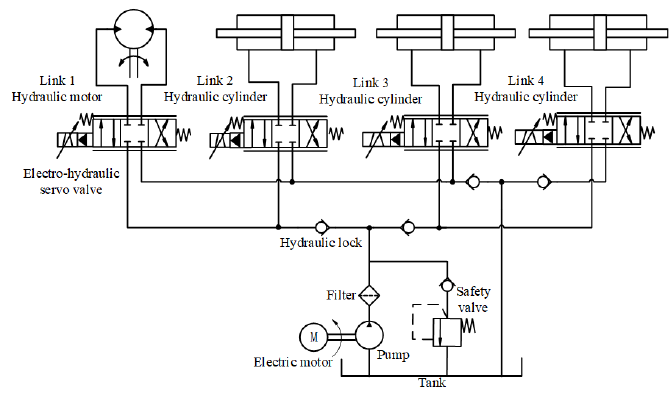
Figure 2. Scheme of hydraulic drive system.